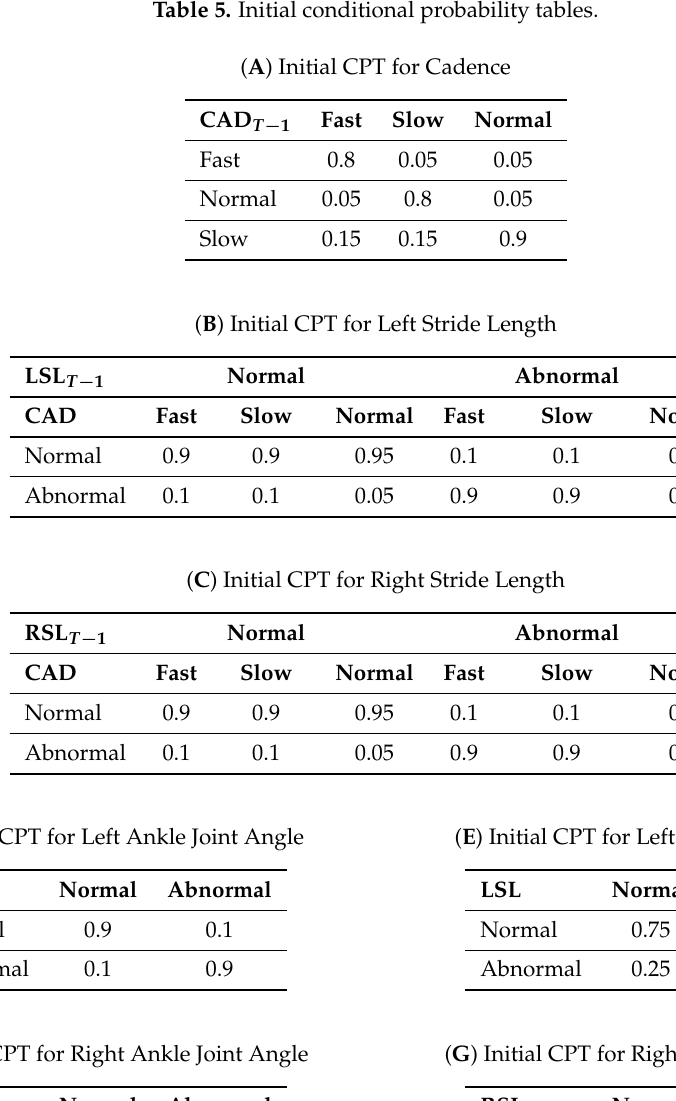
Table 5. Initial conditional probability